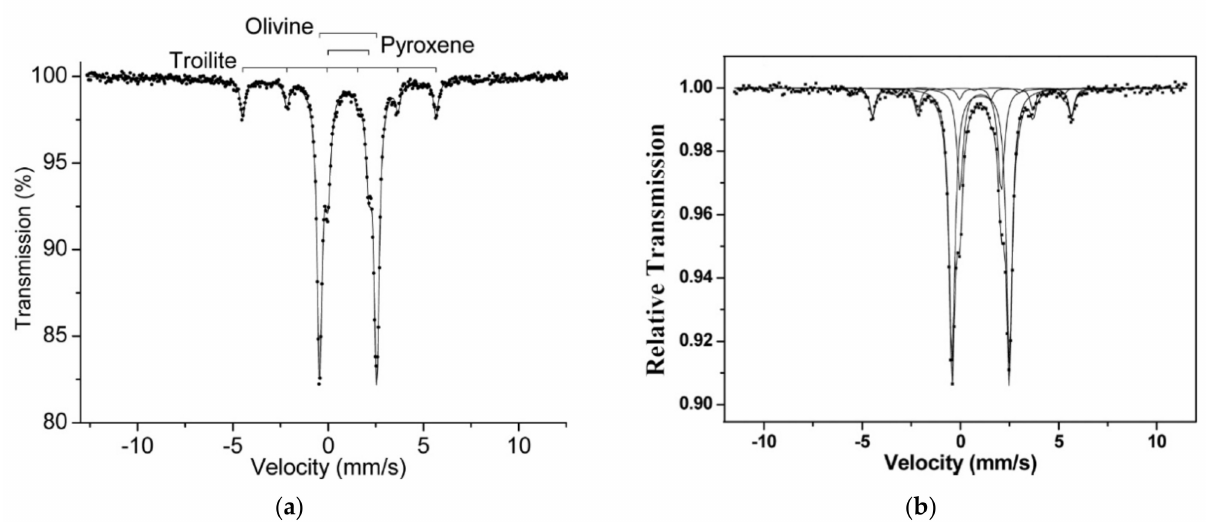
Figure 31. Room temperature Mössbauer spectra of equilibrated ordinary chondrites Bhawad LL6 [56] ( a ) and Al Zarnkh LL5 [103] ( b ). Indicated components are the results of the fits. Adapted from References